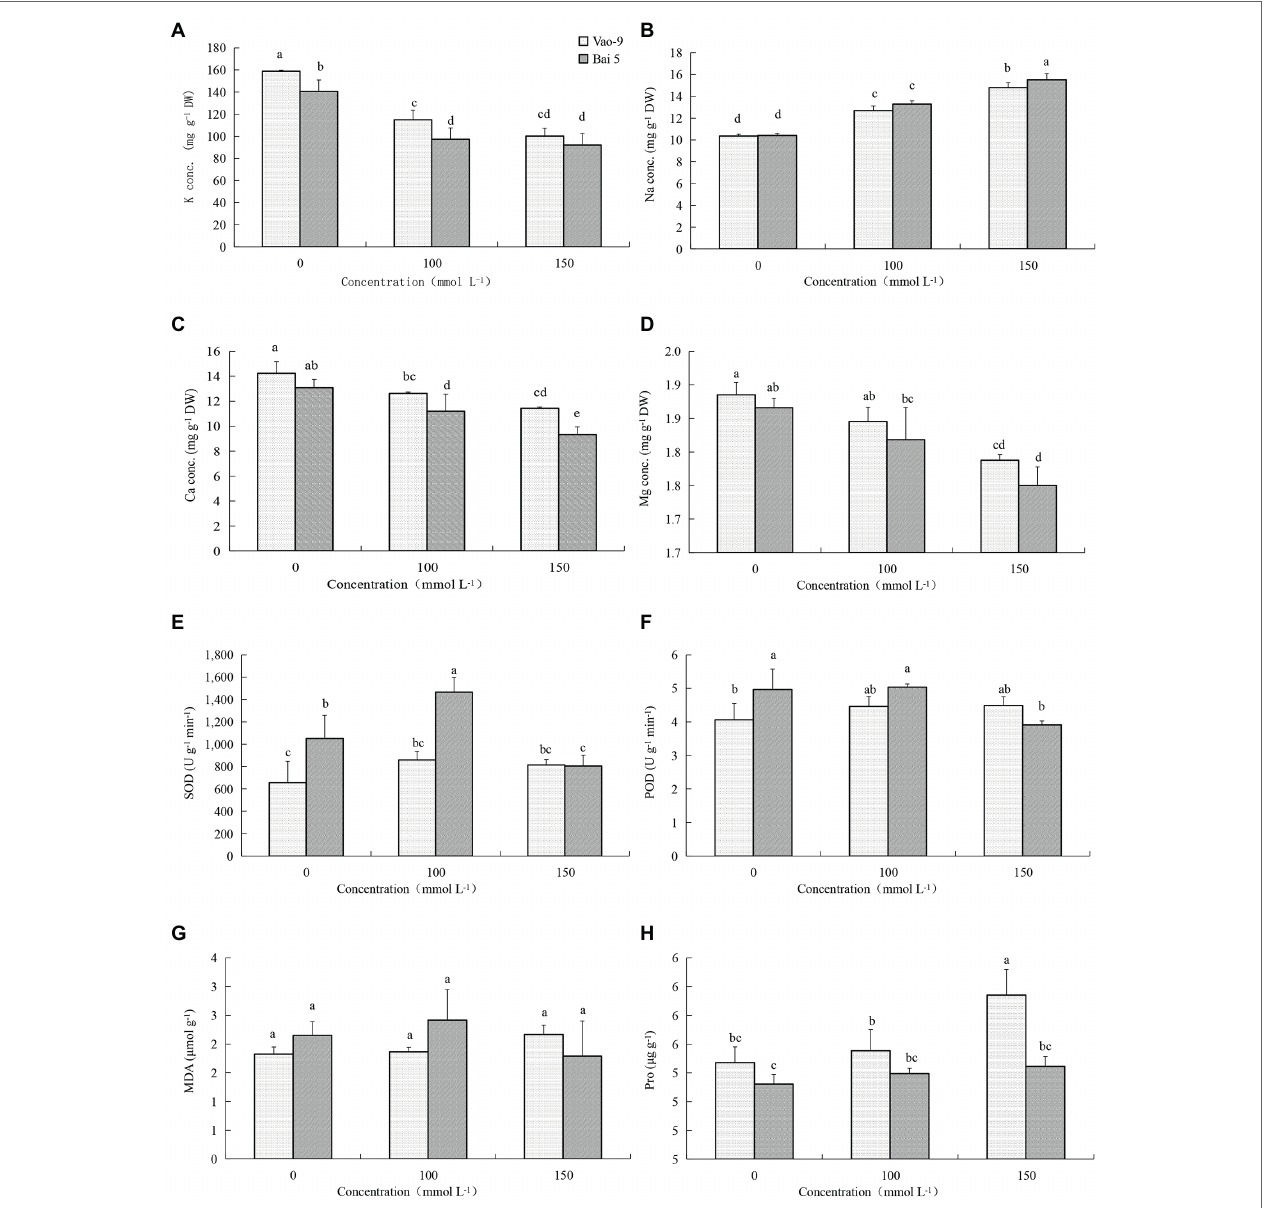
FIGURE 1 | Physiological changes in the leaves of Vao-9 and Bai5 under normal and salt stress conditions. Contents of K + (A) , Na + (B) , Ca 2+ (C) , Mg 2+ (D) , SOD (E) , POD (F) , MDA (G) , and Pro (H) were determined in the leaves of Vao-9 and Bai5 after salt treatments and CK. Data are means ± SD of three biological replicates ( n = 3) and different letters indicate significant difference at p < 0.05 by the One-Way ANOVA